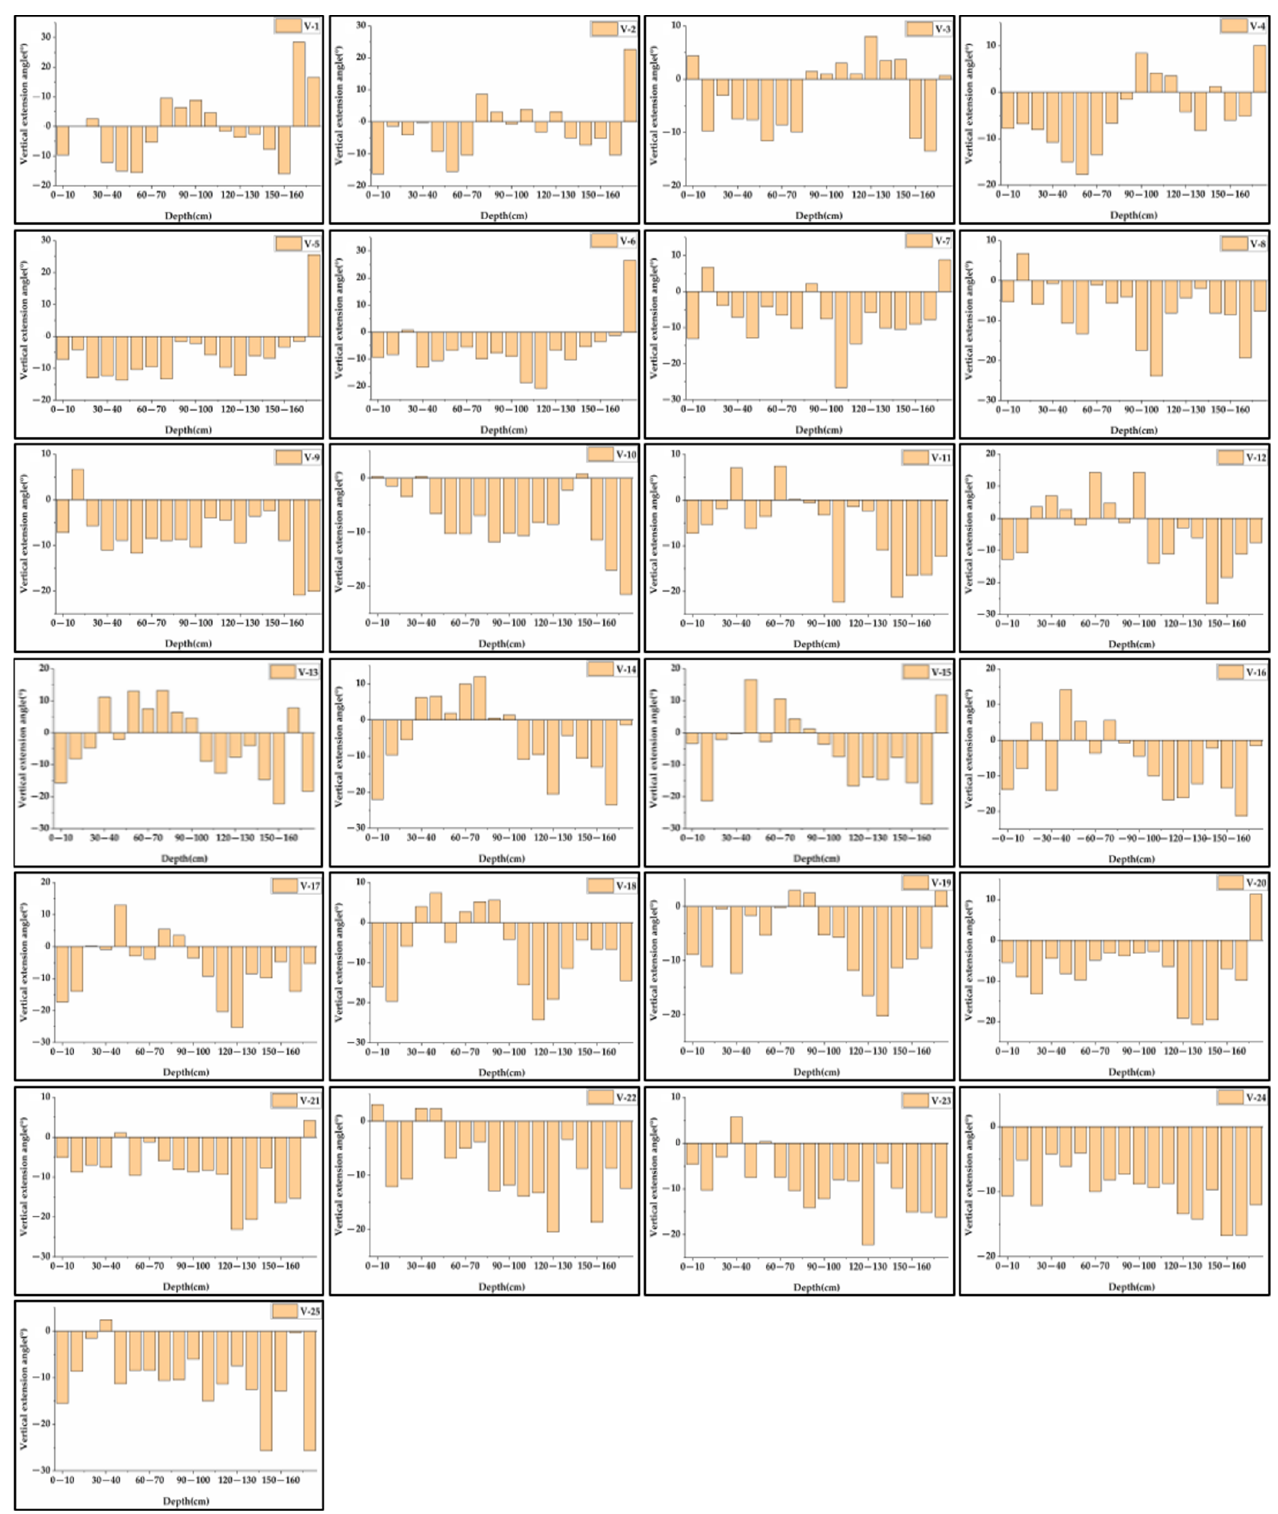
Figure 15. The vertical extension angle of the ground fissure in each longitudinal section varies with depth. (2) Vertical overall extension angle of the ground fissure The vertical overall extension angles of V-13 and V-22 are shown in Figure 16. The green line is the vertical overall extension direction. The diagram shows a bias towards